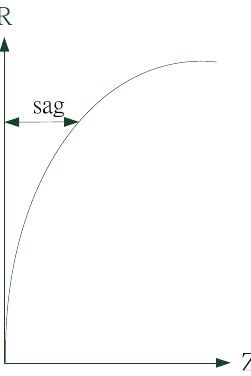
Figure 2. Schematic of aspherical.